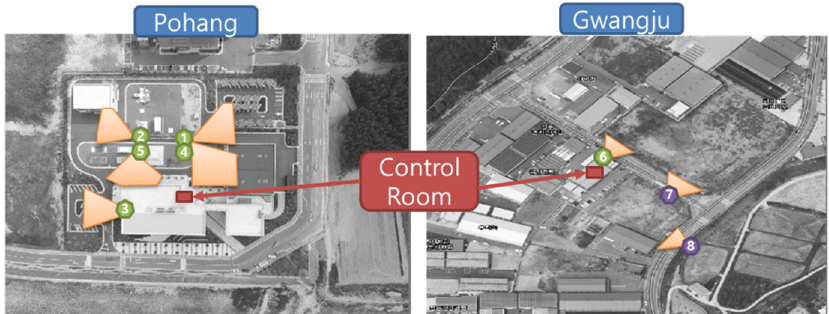
Figure 18. Multi-modal sensor module based 8 fixed agents installation in the Safety Robot Demonstration Center, Pohang (36.119066, 129.415796) and the Nano Industrial Complex, Gwangju (35.244247, 126.835933).